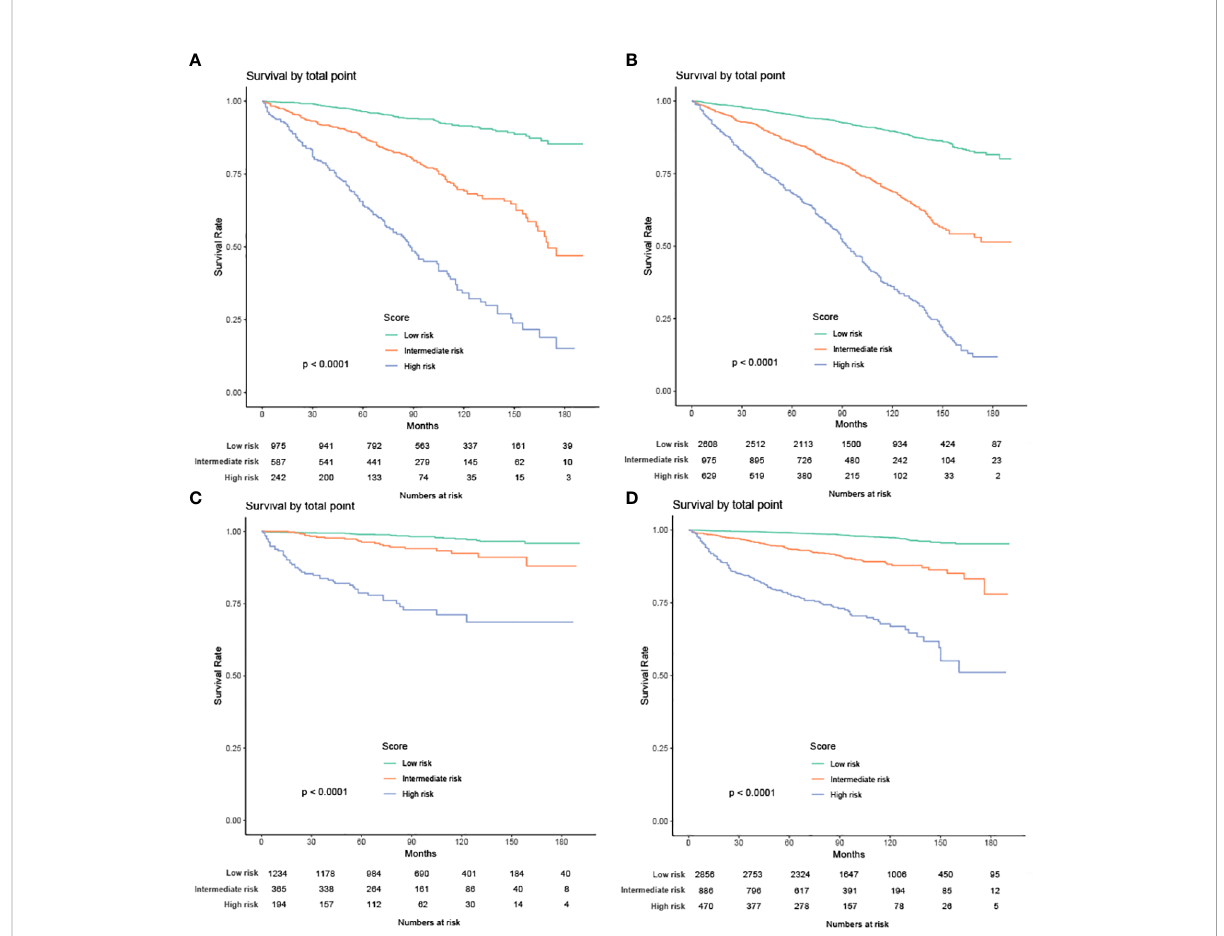
FIGURE 12 Kaplan-Meier curves of the low-, intermediate- and high-risk groups in training group and validation group for OS and CSS (A) Kaplan-Meier curves for OS in training group; (B) Kaplan-Meier curves for OS in validation group; (C) Kaplan-Meier curves for CSS in training group; (D) Kaplan-Meier curves for CSS in validation